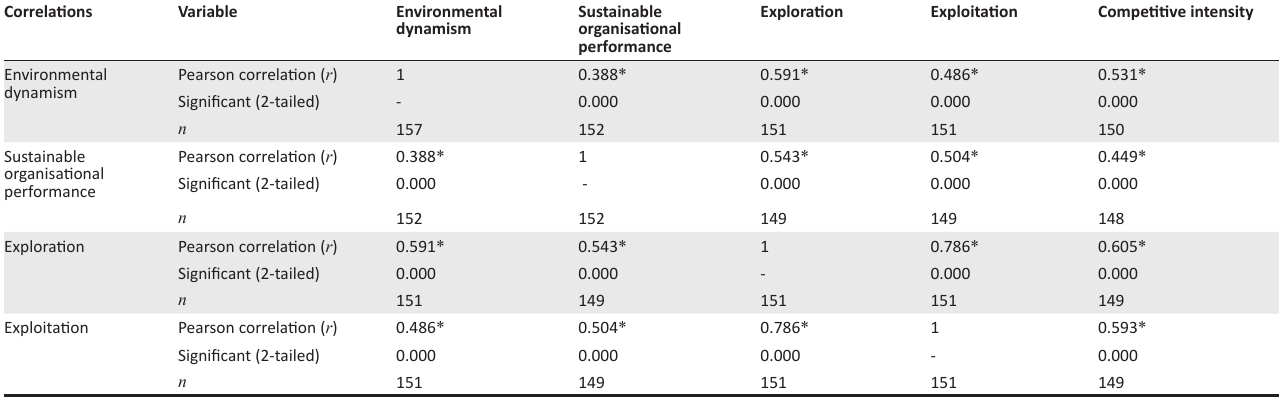
TABLE 2-A1: Pearson’s product–moment correlation test results between the five dimensions. Correlations